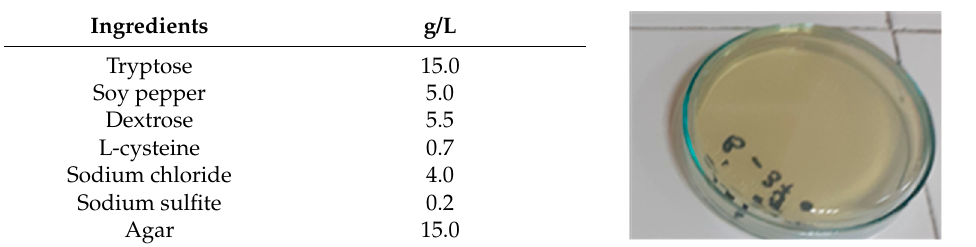
Table 1. Ingredients needed to reactivate S. pyogenes and S. aureus batteries. Ingredients